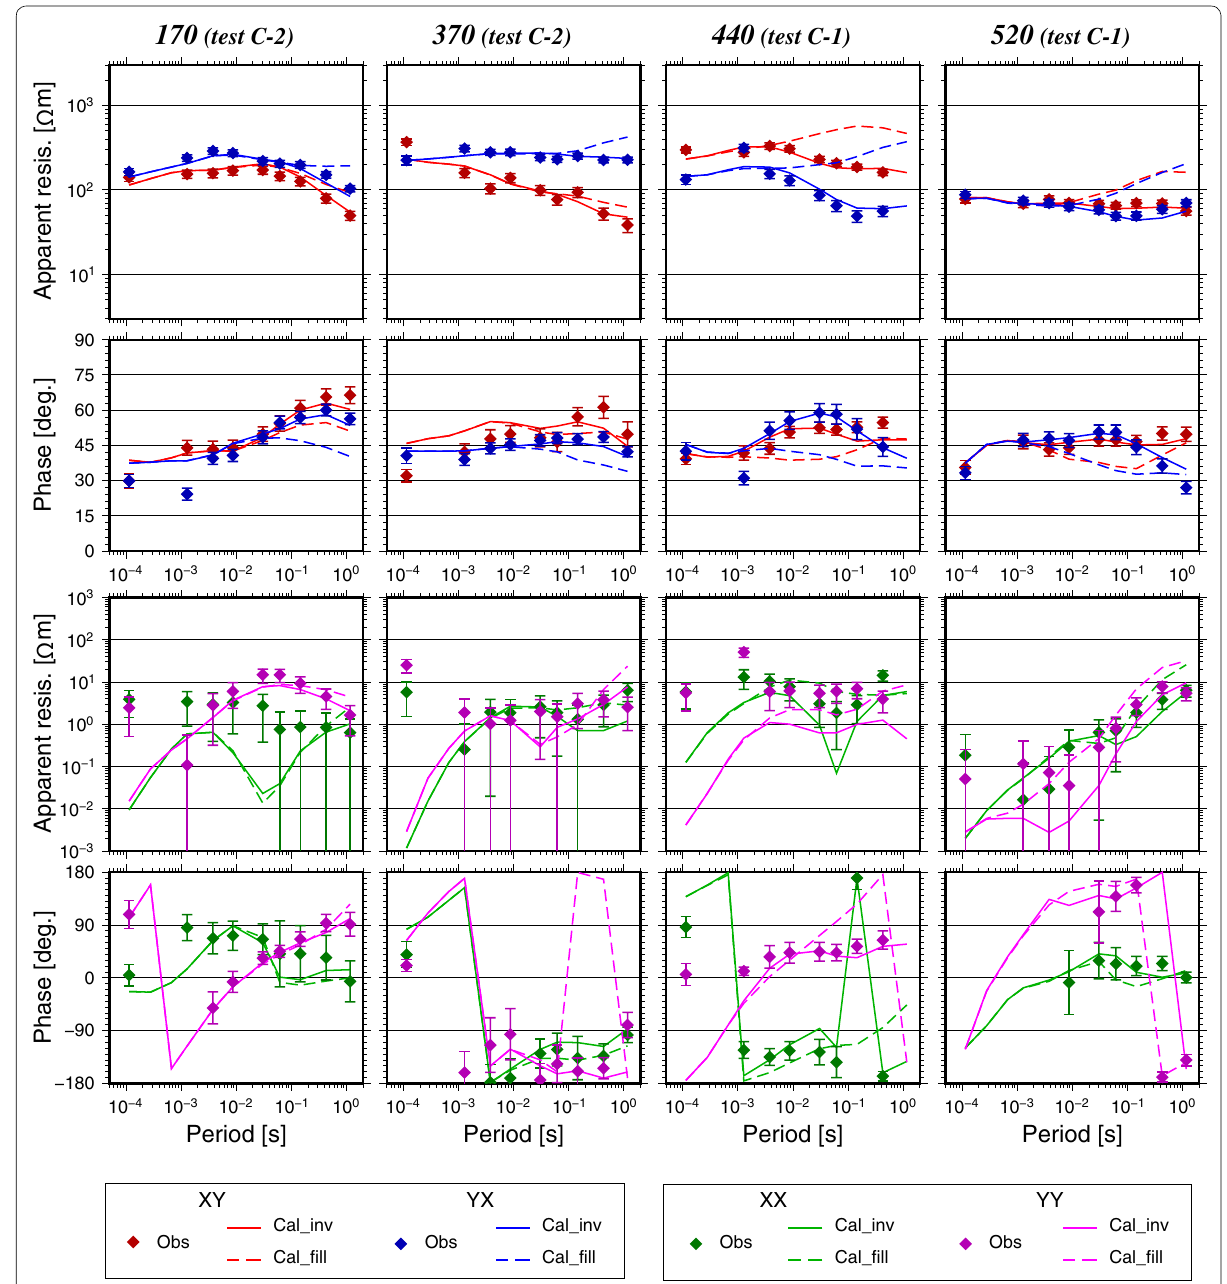
Fig. 2 Apparent resistivity and phase of MT impedances. Circles labeled “OBS” denote MT responses based on the observation. Note that the error bars include error floors for the inversion. Solid lines labeled “Cal_inv” denote model response of the inverted model. Dashed lines labeled “Cal_fill” denote the filled models. The C-2 filled model is for the sites 170 and 370, and the C-1 filled model is for sites 440 and 520. 180 degrees were added to the phases of the YX